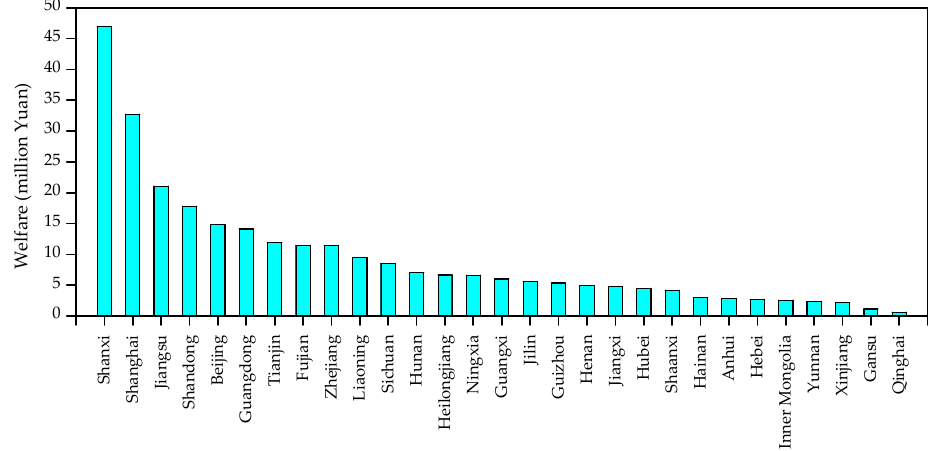
Figure 7. Welfare effect of each province in descending order under target 1.